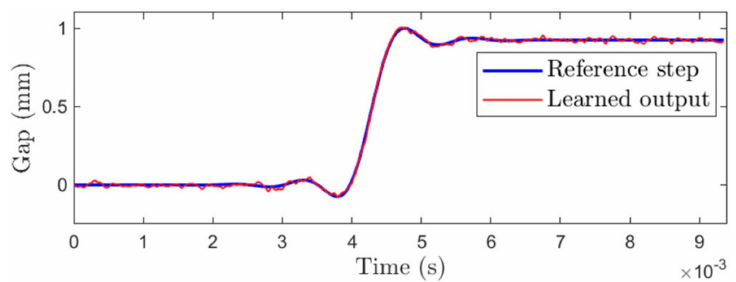
Figure 12. Simulation curve of suspension system step response.